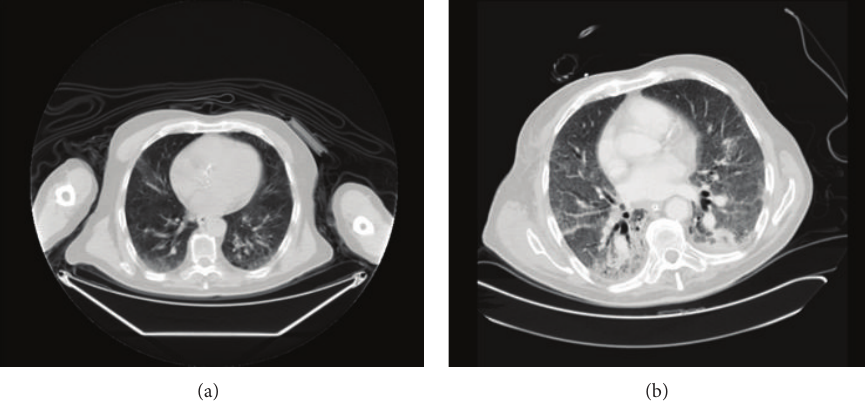
Figure 2: (a) Chest CT scan of patient 2, three months prior to development of respiratory symptoms. (b) Chest CT scan of patient 2, at the beginning of respiratory symptoms: diffuse interstitial infiltrates shown in both